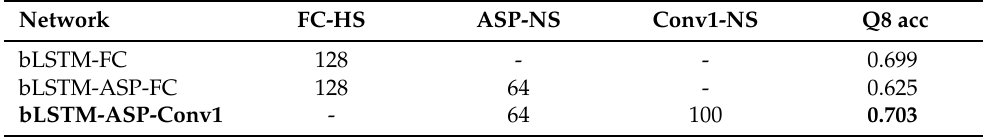
Best model and best score are marked as bold